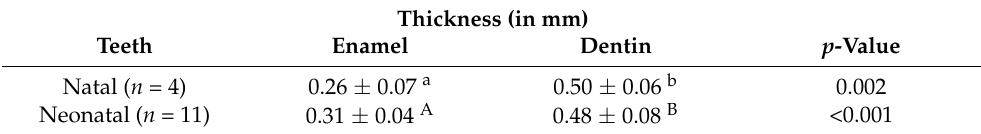
Table 1. Maximum enamel and dentin thicknesses (in mm) in natal/neonatal teeth.